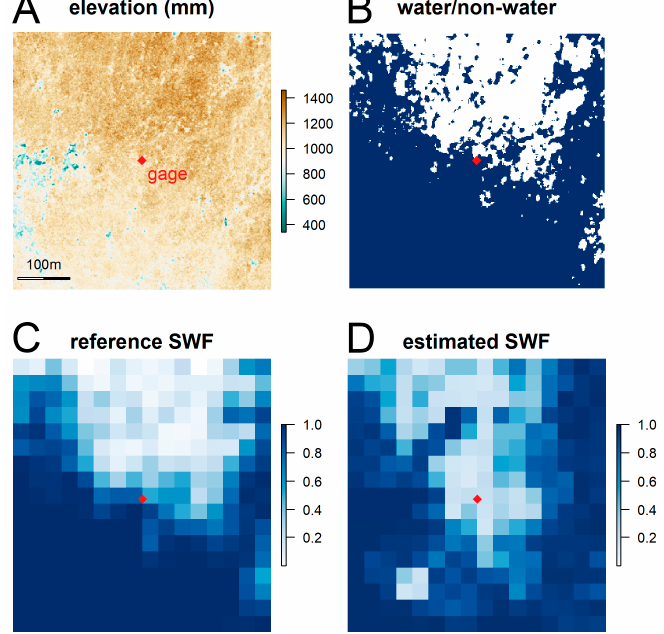
Figure 3. Demonstration of the Digital Elevation Model (DEM)-flooding methodology for one sub-site in the Everglades. A 5-foot (~1.5 m) resolution DEM ( A ) is used together with the water depth measured at the gage to create a water/non-water mask ( B ). The mask is then resampled to 30-m resolution to generate a reference SWF ( C ), to which the estimated SWF ( D ) is